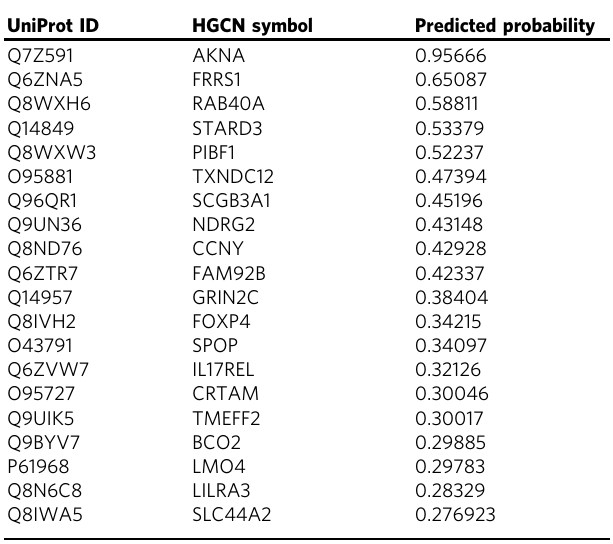
Table 2 A list of the top 20 genes predicted from the AD- speci fi c MPXgb model.